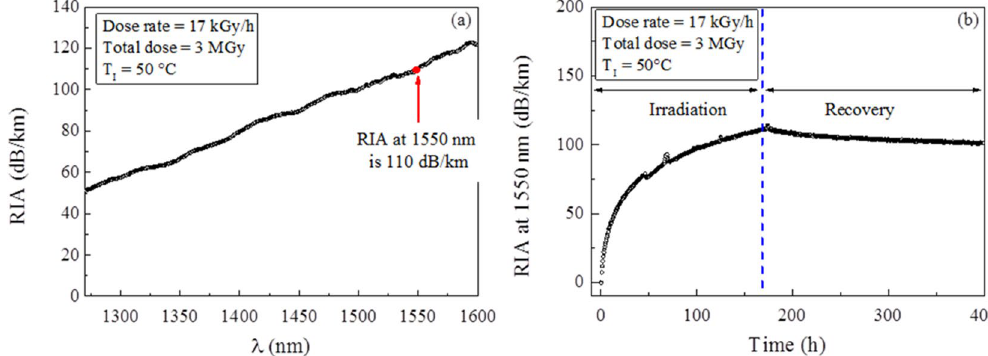
Figure 3. Radiation Induced Attenuation evaluation. ( a ) IR spectral RIA after γ -irradiation at 3 MGy (the dose- rate is 17 kGy/h and the irradiation temperature is 50 °C) ad ( b ) RIA evolution at 1550 nm as a function of the time during irradiation up to 3 MGy and